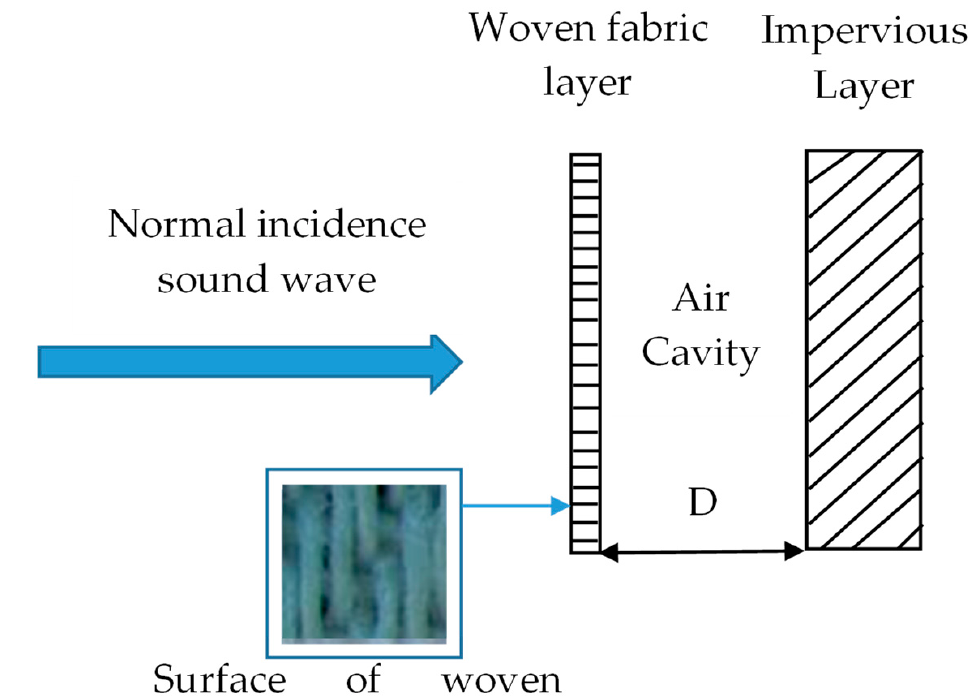
Figure 4. The basic structure of the MPP system considered in this study.